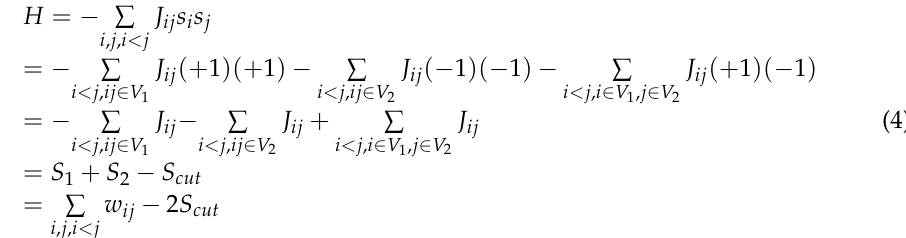
Figure 5. Schematic diagram of the max-cut problem.